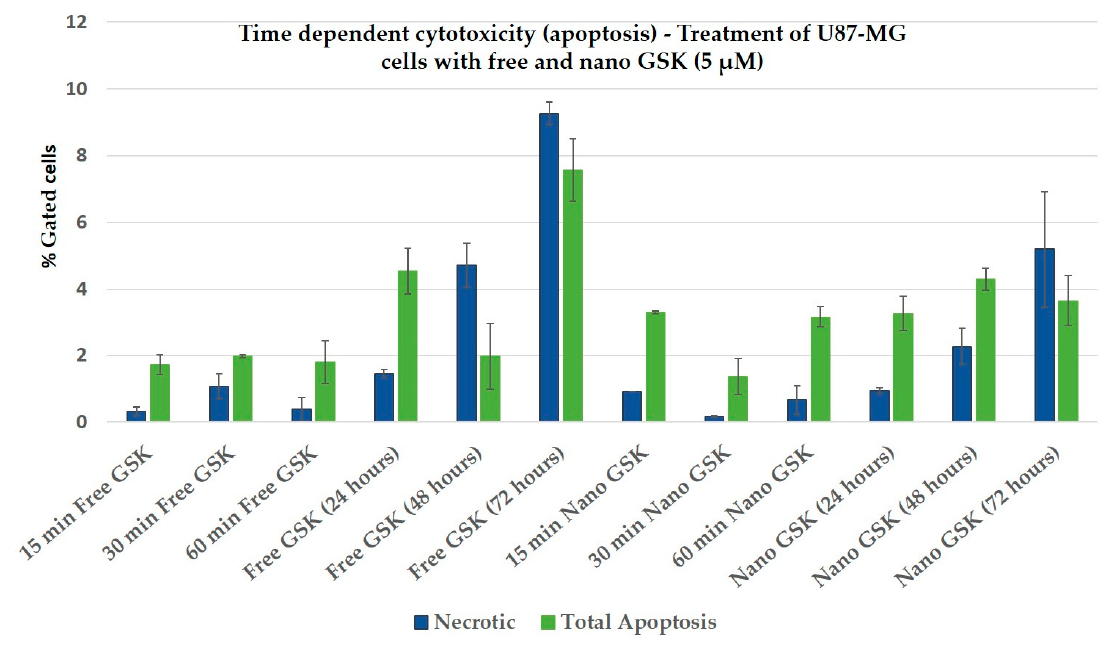
Figure 10. Bar graphs showing the percentage of apoptotic and necrotic cells following treatment with either free GSK or nano GSK at a drug concentration of 5 µ M. The percentage of necrotic as well as apoptotic cells from the “no treatment” control were subtracted from all of these treatment arms and plotted here. Error bars indicate standard deviation.